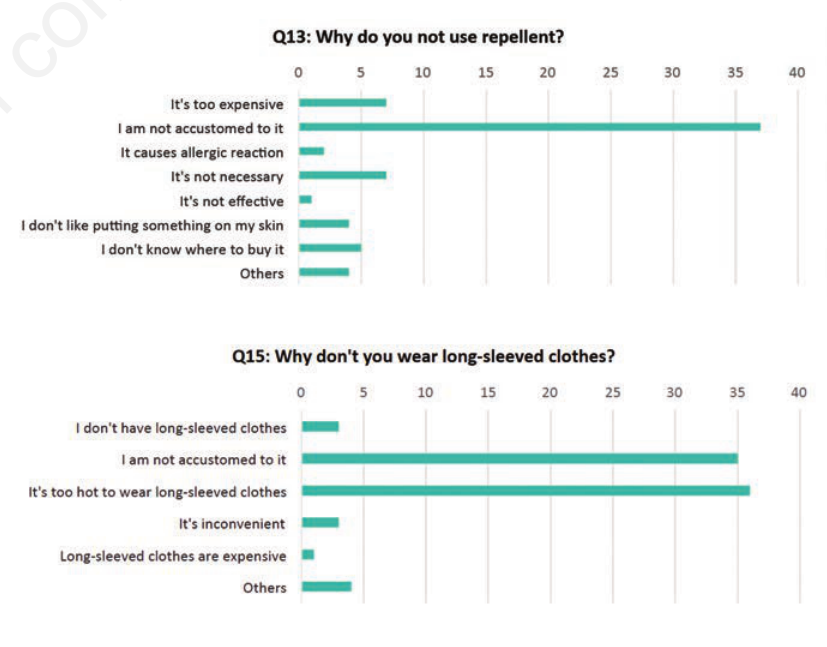
Figure 1. Selected histograms of Behavior Questions responses